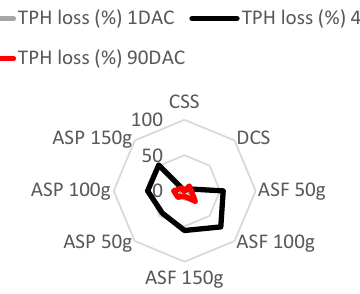
Figure 5. Percentage total petroleum hydrocarbon (% TPH) loss in the E. crassipes amended diesel contaminated soil CSS = Control Soil, DCS = Diesel Contaminated Soil, ASF = Amended Soil with Fresh E. crassipes , ASP = Amended Soil with Powdered E. crassipes , DAC= Days After